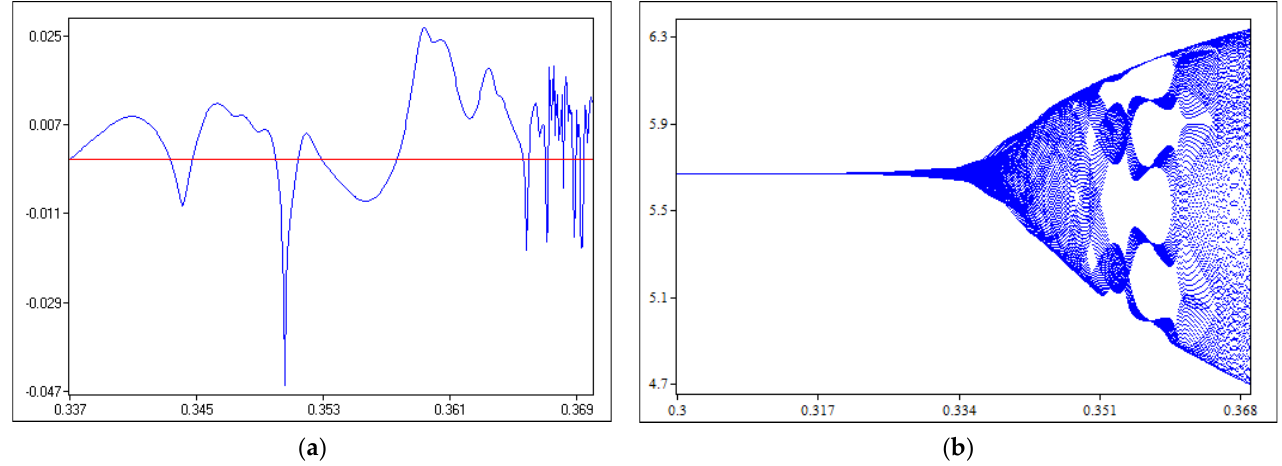
Figure 5. Adjustment coefficient changing: ( a ) maximum Lyapunov exponent for µ 3 = ( 0.337;0.369 ) ; ( b ) bifurcation diagram for quantity of the 1st firm when µ 3 = ( 0.3;0.369 )